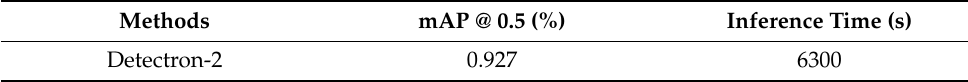
Table 8. The performance of the two-stage detector for